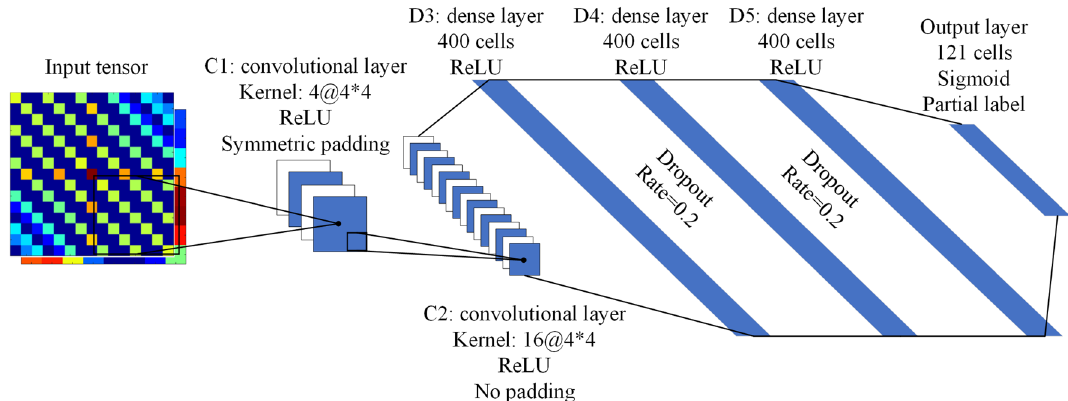
Figure 2. Framework of the proposed simple estimation